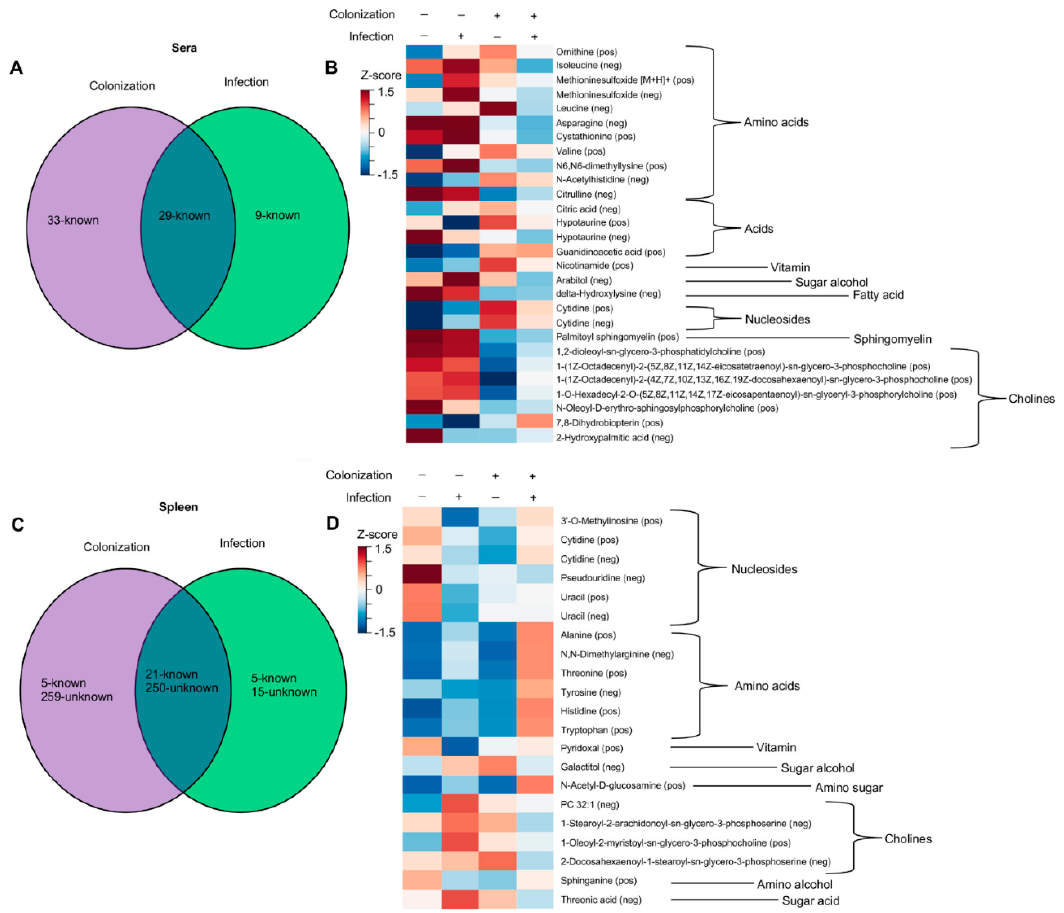
Figure 3. Abundances of certain metabolites is altered by colonization and MuLV infection. ( A , C ) Venn diagrams illustrating the numbers of metabolites significantly altered by colonization, infection, or both in the sera ( A ) or spleen ( C ). ( B , D ) Heatmaps of identified metabolites, clustered by chemical type, whose abundances are influence by colonization, MuLV infection, or both in the sera ( B ) or spleen ( D ). Normalized values for each group were averaged and constructed into a heat map where red color indicates high metabolite levels, and blue color indicates lower metabolite levels. p -values were adjusted using Bonferroni correction [27] followed by two-way ANOVA to identify metabolites influenced by two independent variables: the presence of L. murinus and the virus. Each row is a